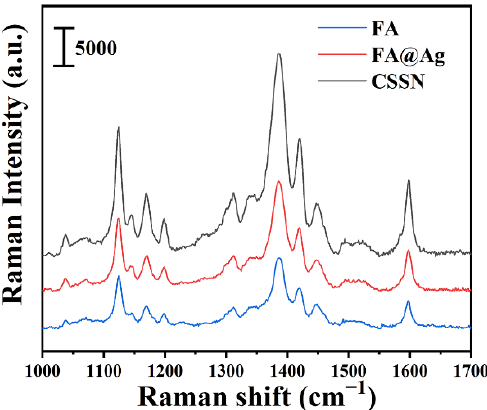
Figure 4. SERRS spectra after azo reaction of BPA azo products (10 −4 M) on FA, FA@Ag, and CSSN NCs.